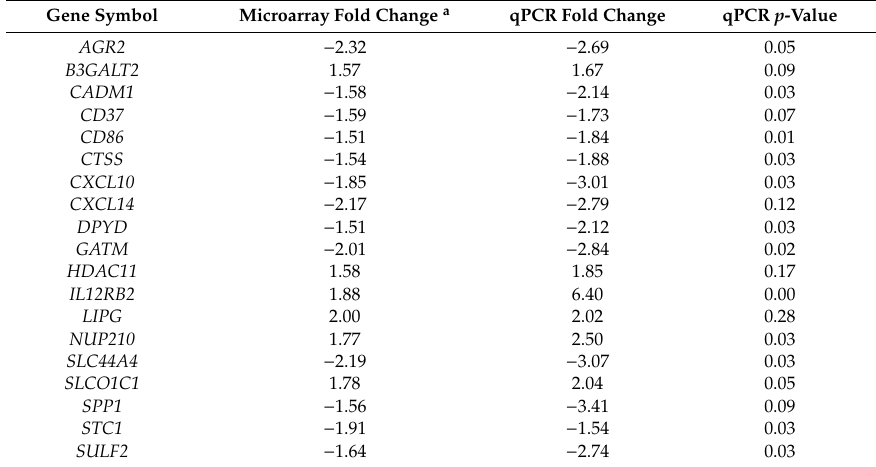
Table 2. Comparison of mRNA expression for selected genes identified using microarray or qPCR analyses in NR non-IUGR versus NR IUGR placentomes.